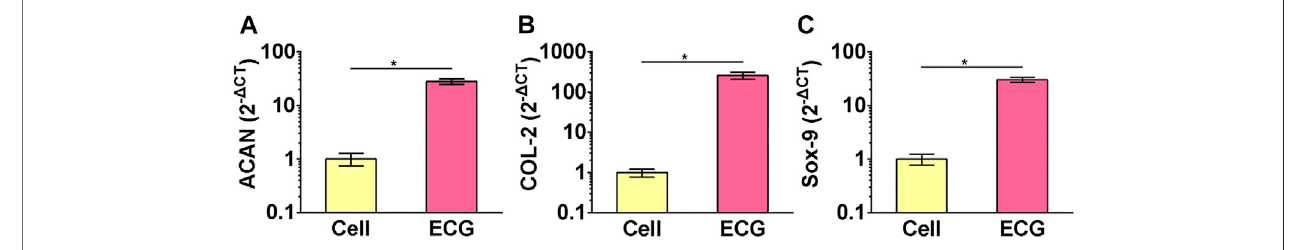
FIGURE 2 | QPCR analysis of chondrocytes and ECG. Gene expression of ACAN (A) , COL-2 (B) and Sox-9 (C) in chondrocytes and ECG after 5 days in vitro culture. * p < 0.05.